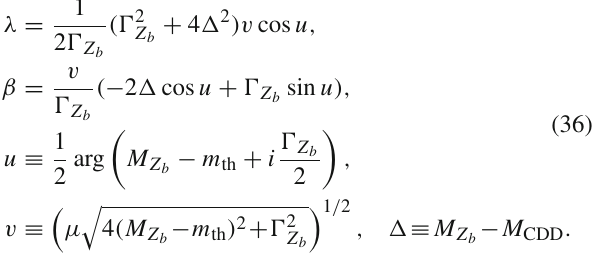
Fig. 1 Mass spectra of Z b ( 10610 ) and Z b ( 10650 ) . The left (right) one is for B ¯ B ∗ ( B ∗ ¯ B ∗ ) invariant mass spectrum and the relevant Z b ( 10610 ) ( Z b ( 10650 ) ) resonance. Points with error bar are the experimental data from Belle Collaboration [3]. The vertical lines correspond to